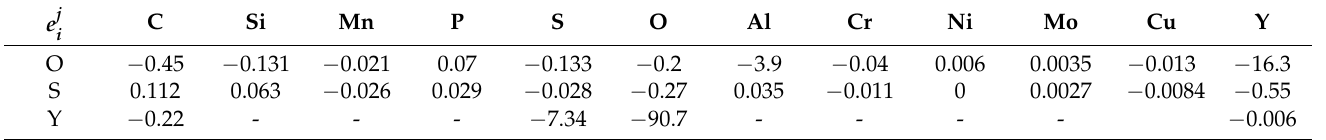
of various elements in molten EH36 steel at 1873K. i